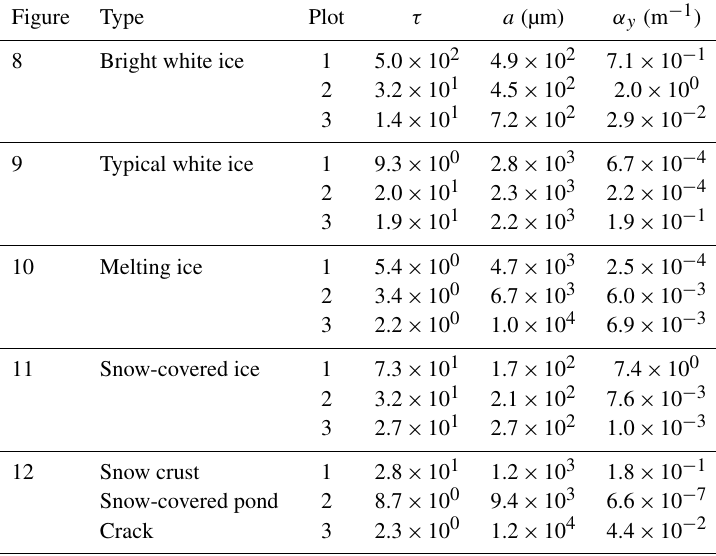
Figure 12. Three special cases: thin wind crust on top of fine fresh snow of 4cm thickness (left panels), a frozen-over gray melt pond with snow on top (middle panels), and a frozen-over crack with air bubbles and algae inclusions (right panels). The average air temperature is + 0.3 ◦ C (right panels) and − 1.6 ◦ C (the others). Table 2. Retrieved parameters of white ice. See Table 1 for explanation of parameters. Figure Type